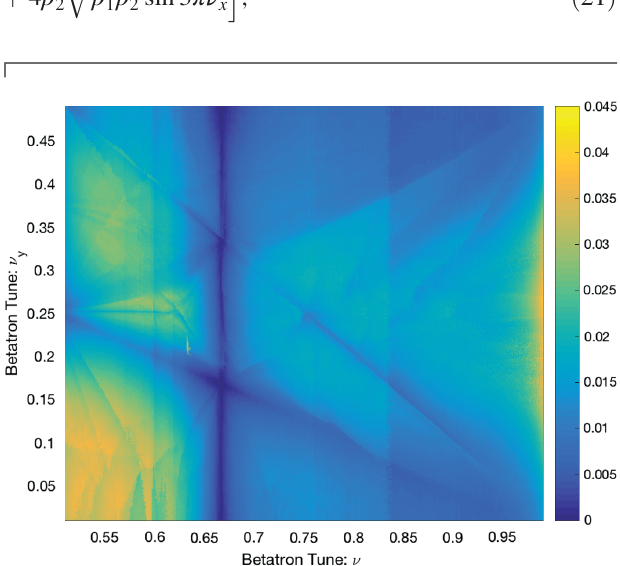
FIG. 12. A tune scan of the dynamic apertures. The color scale represents the averaged dynamic aperture in the normalized ffiffiffiffi p L coordinates divided by ϕ